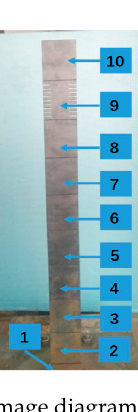
Figure 8. The first two shapes of the cantilever beam with 0.4 m immersion depth.